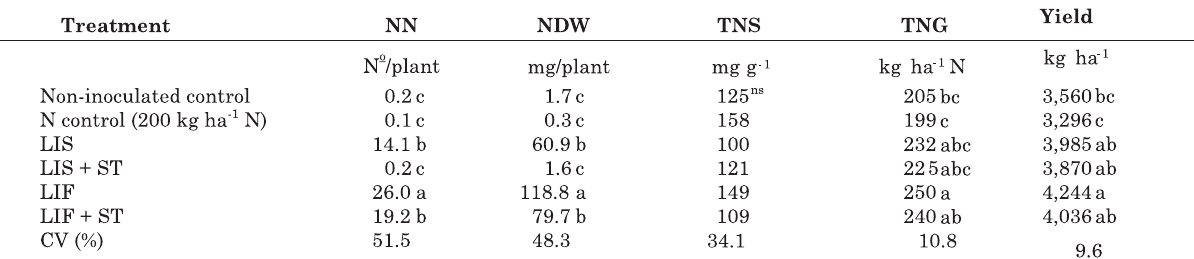
Table 8. Nodule number (NN) and dry weight (NDW) at the V4 stage, total N in shoots (TNS) at the R2 stage, total N grain content (TNG), and grain yield at harvest of soybean inoculated with liquid inoculant on the seed (LIS) or in the planting furrow (LIF), with or without seed treatment (ST) with fungicides and micronutrients (1) . Experiment conducted in Taciba, São Paulo, in the 2002/2003 growing season, in a soil treated with inoculant for the first time (<10 1 cells g -1 of soil) (2)